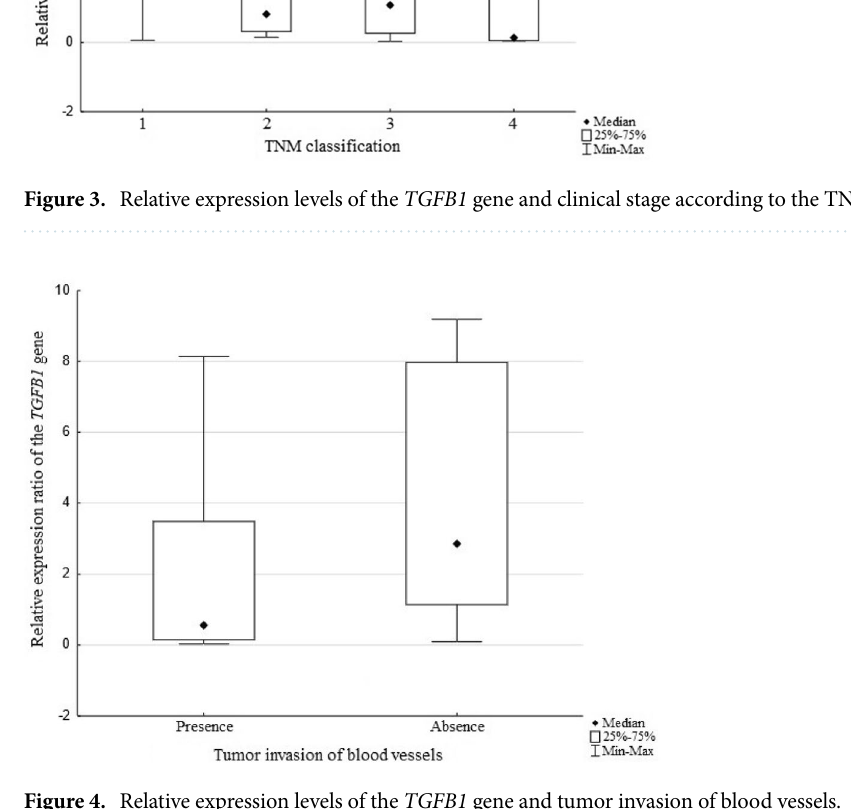
Figure 4. Relative expression levels of the TGFB1 gene and tumor invasion of blood